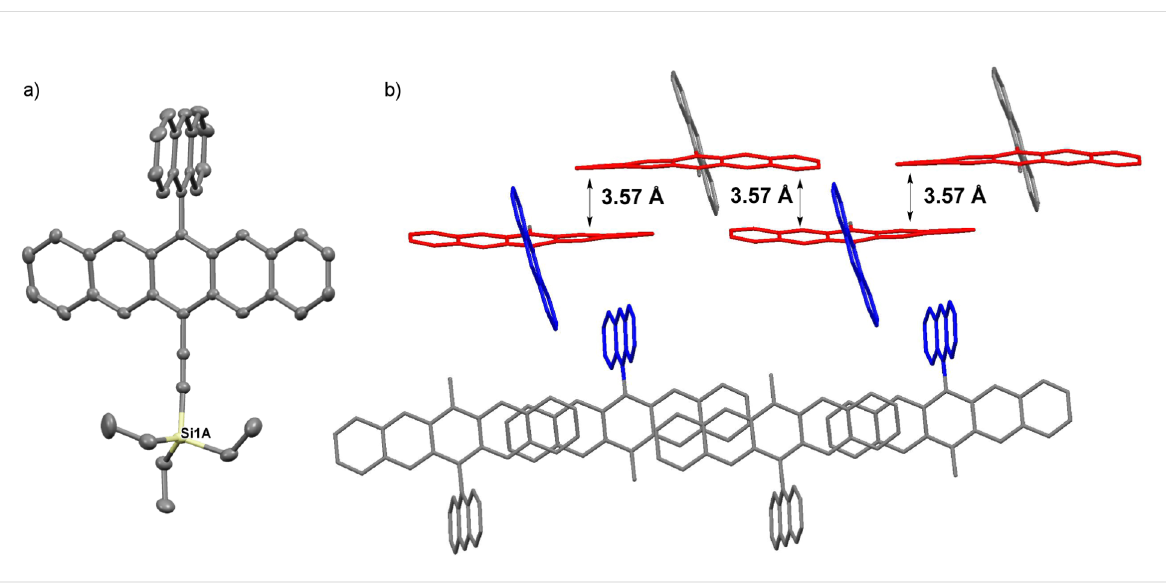
slipped stack motif along the crystallographic c- axis, with π - stacking distances of 3.28 Å and 3.35 Å. Pentacene derivative 3j crystallizes in the space group P -1 with two molecules in the unit cell (Figure 12). Interestingly, the pentacene core and the naphthyl group are nearly coplanar